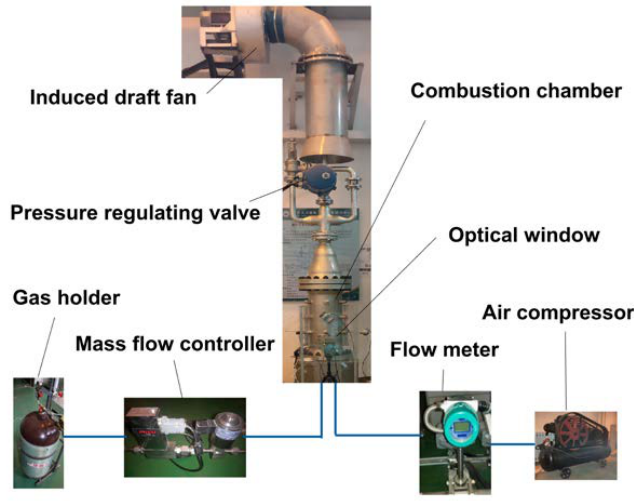
Figure 1. High-pressure combustion test rig schematic diagram.